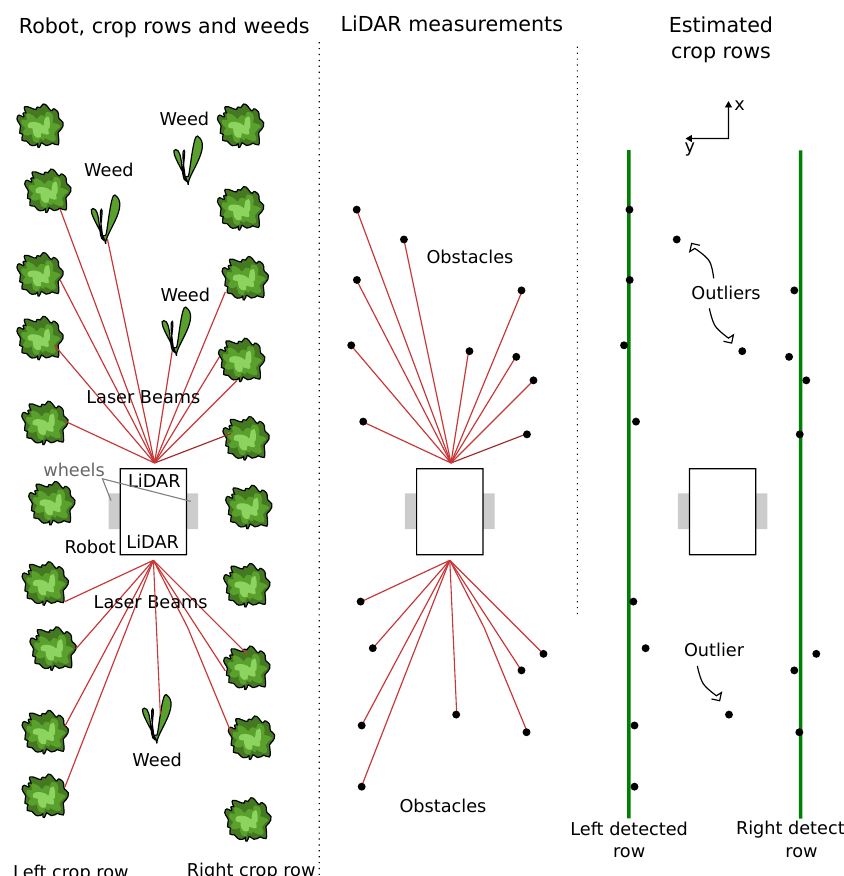
Figure 2. The line finding problem: The objective is to identify the crop rows from LiDAR data. The left part of the figure depicts a top view of the scene (a robot moving between two crop rows), the middle part depicts the data from the sensors (i.e., points corresponding to plants) and the right part shows an ideal result from the line finding algorithm (that is, the left and right crop rows have been identified from the LiDARs data